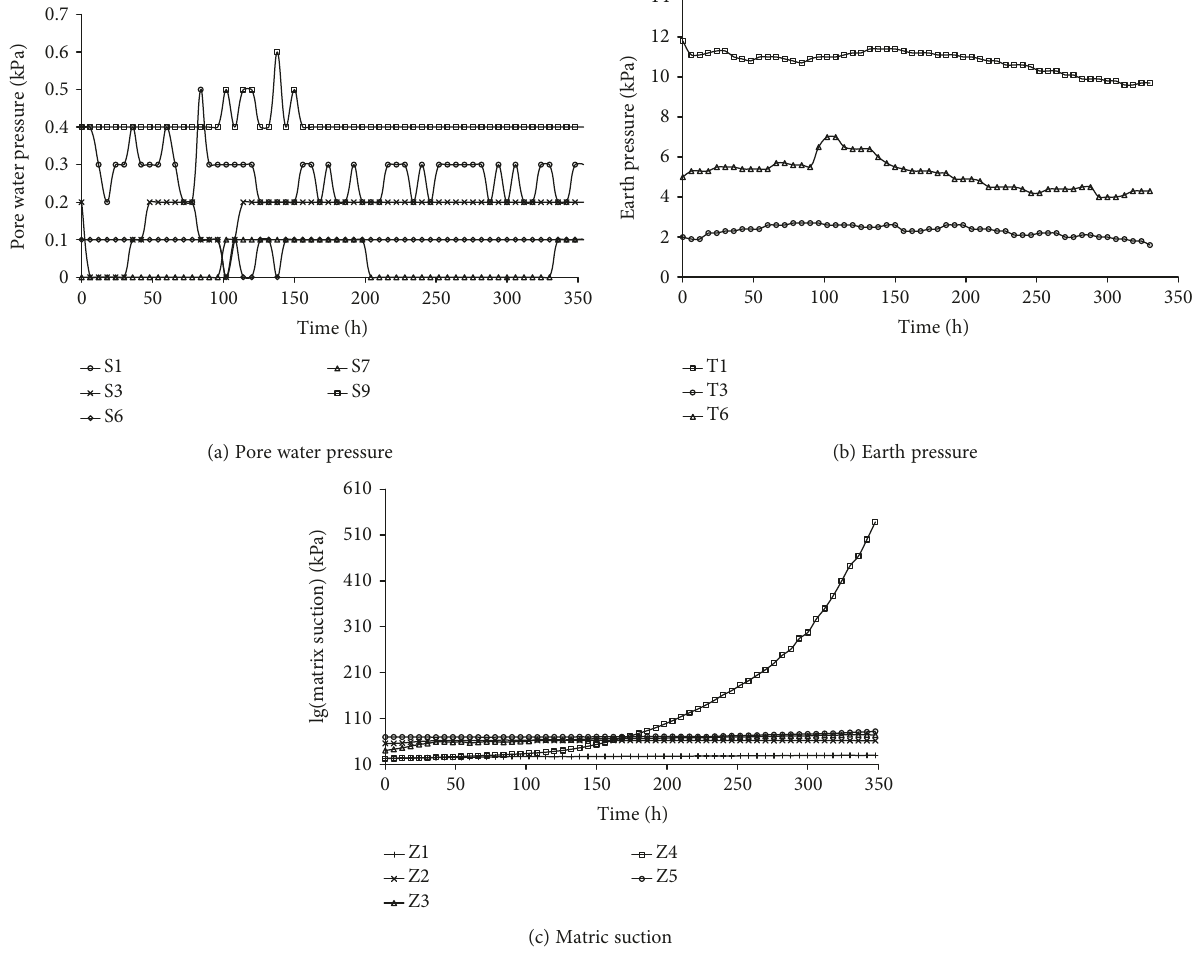
Figure 9: Results during the drought period.